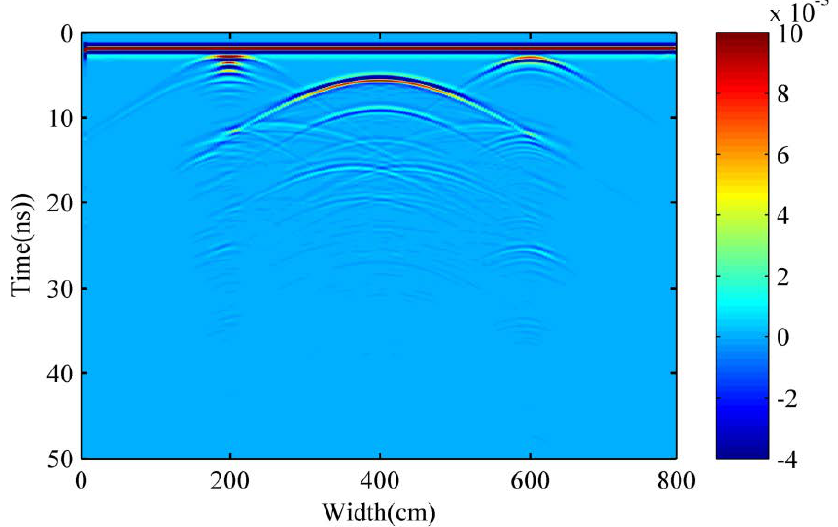
Figure 17. GPR B−scan images of underground cavity mode. Figure 17. GPR B − scan images of underground cavity mode.